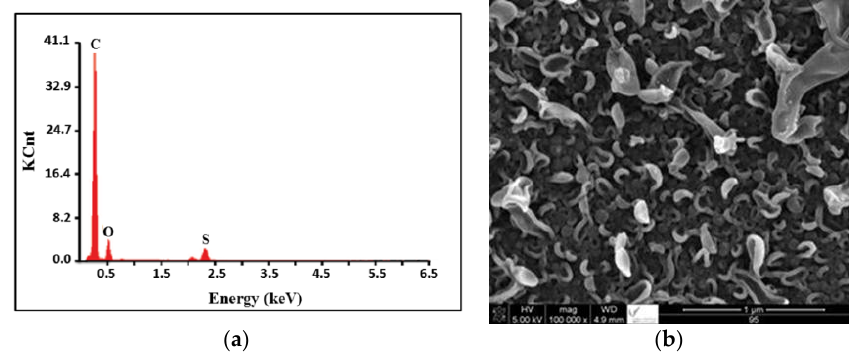
Figure 2. EDX spectrum ( a ) and ( b ) SEM image of TFC reference.